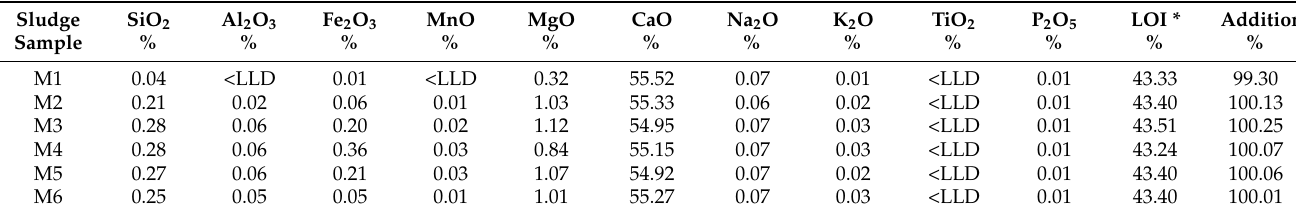
Table 2. Chemical composition of the waste sludges obtained by X-ray fluorescence. M1 to M6 represent successively each of the individual marble waste sludge samples.